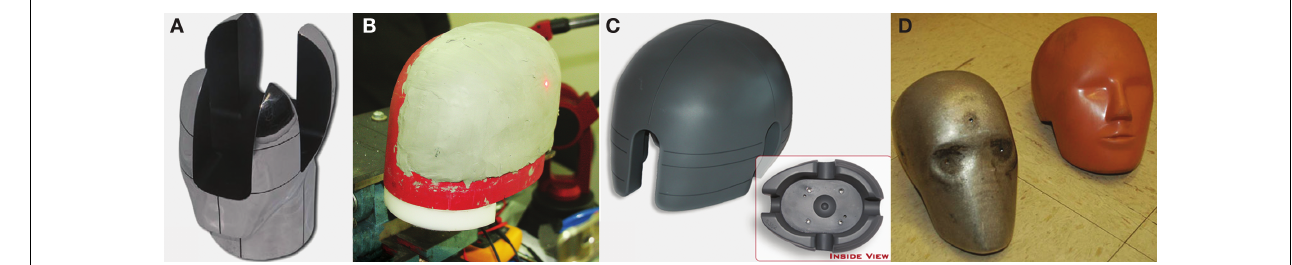
peak acceleration criterion. (\protect\char” 007 B\relaxwww.cadexinc.com}) (D) Hybrid III head form for measuring blunt trauma used with the Head Injury Criterion. (Bass CR, Walilko TJ, Kent R. Evaluation of head surrogates for the assessment of explosive and ballistic injuries. Final report submitted to the Combatting Terrorism Technology Support Office by University of Virginia. April 2011. Contract Number W91CRB-09-0015).